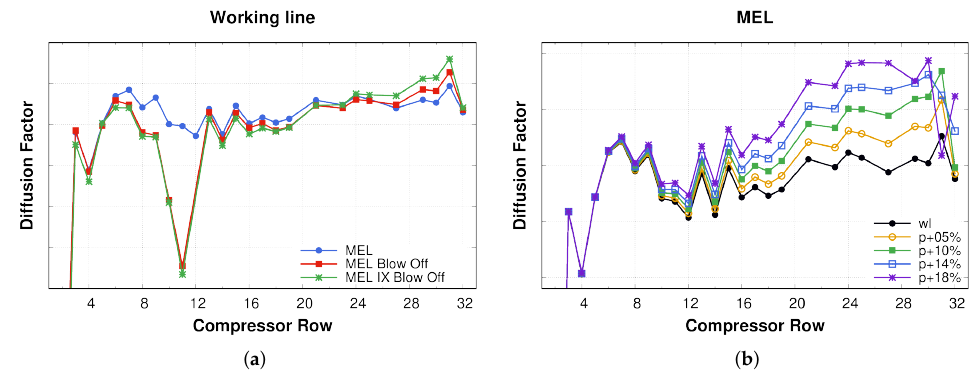
Figure 7. Diffusion factor comparison between analyzed MEL configurations ( a ) and part-load standard MEL operating condition ( b ).